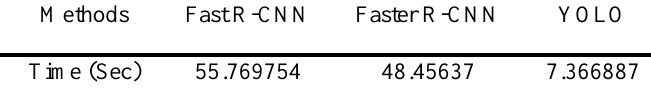
Table 5. Comparative analysis based on time (example